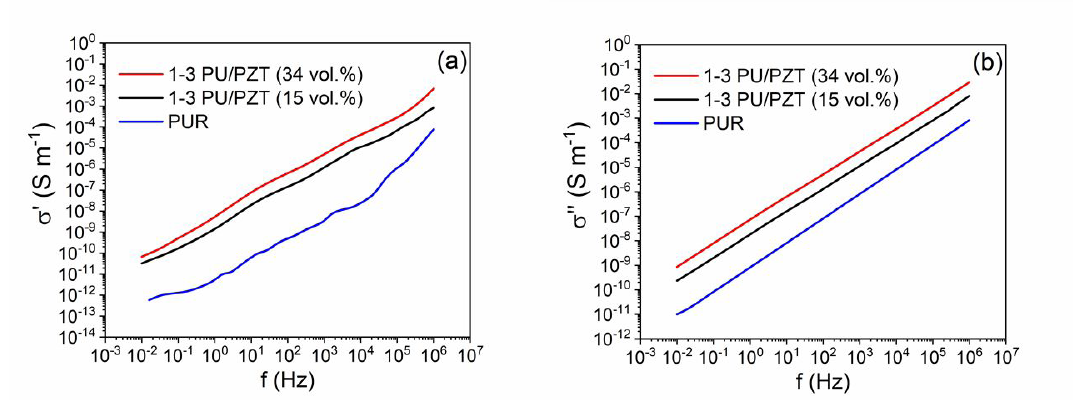
Figure 5. Ac conductivity of the neat PUR and 1-3 PUR/PZT piezoelectric composite with different volumetric fraction of PZT rods. (a) real and (b) imaginary part of the electrical conductivity as a function of frequency at room